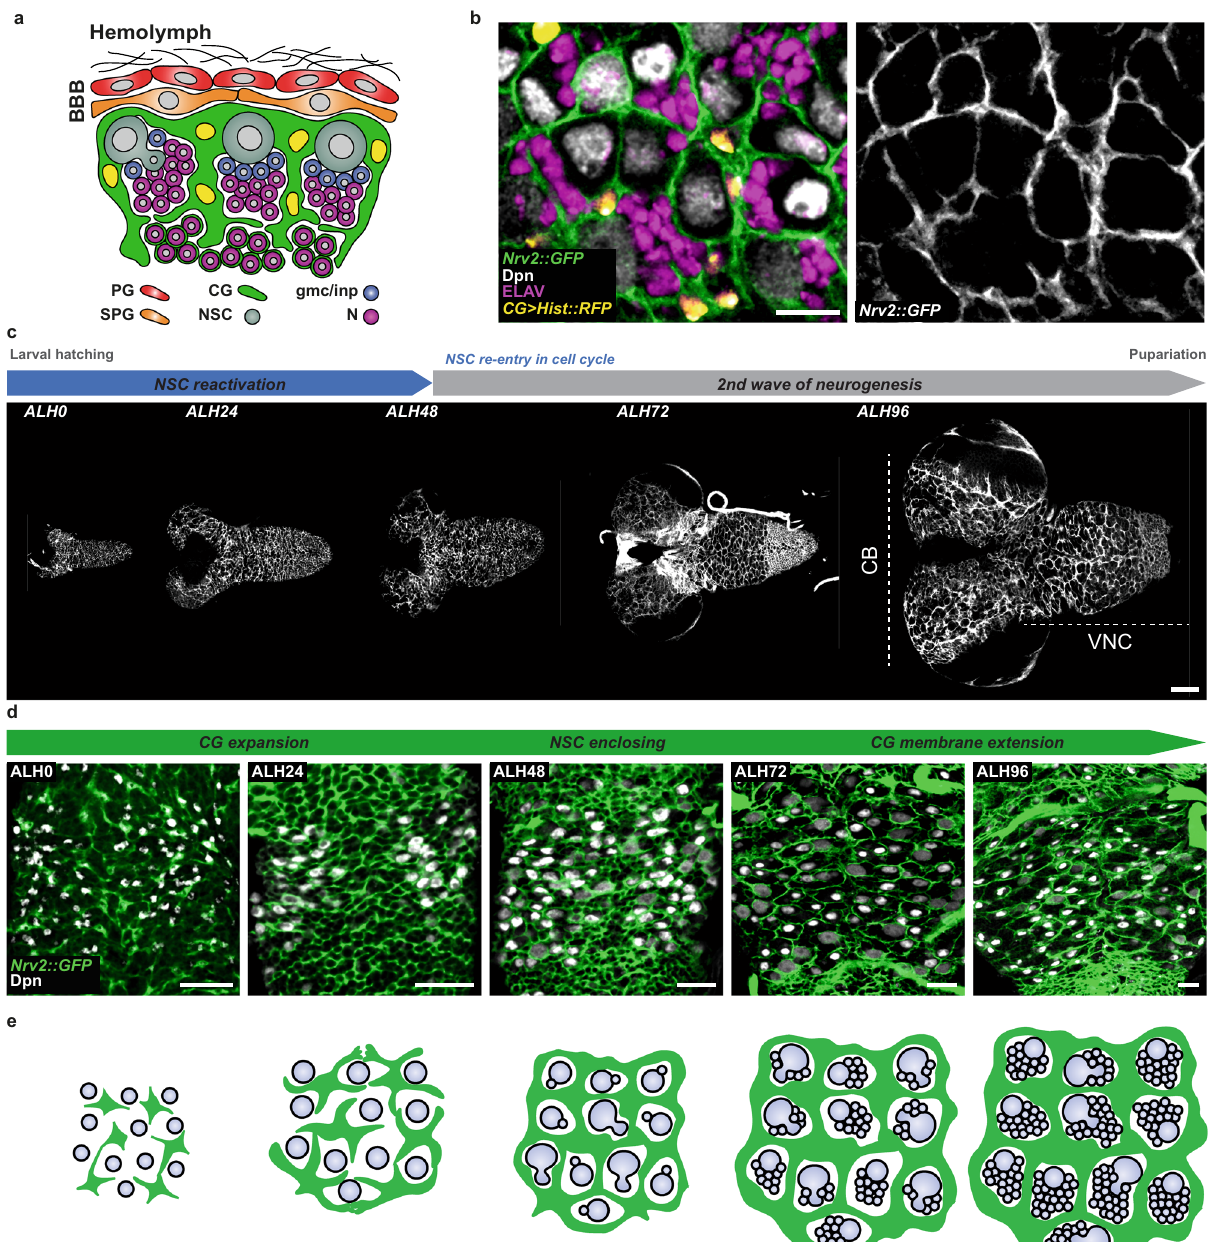
Fig.1|GrowthofindividualCGcellsresultsinatiledorganisationofthecortex glia network. a Schematic of the Drosophila NSC niche depicting the blood brain barrier(BBB),whichismadebytheperineurialglia(PG,red)andsubperineurialglia (SPG, orange), the cortex glia (CG, green), neural stem cells (NSC, grey), ganglion mother cells/intermediate progenitors (gmc/inp, blue) and neurons (N, magenta). b Ventral region in the larval ventral nerve cord (VNC) at ALH72 (at 25°C) labelled with markers for the CG membranes ( Nrv2::GFP , green), CG nuclei ( CG > Hist::RFP , yellow), NSC (anti-Dpn, grey) and neurons (anti-ELAV, magenta). The right panel shows the CG membrane separately. Scale bar: 10 μ m. c Timeline of neurogenesis (top scheme) and assessment of CG network organisation during larval